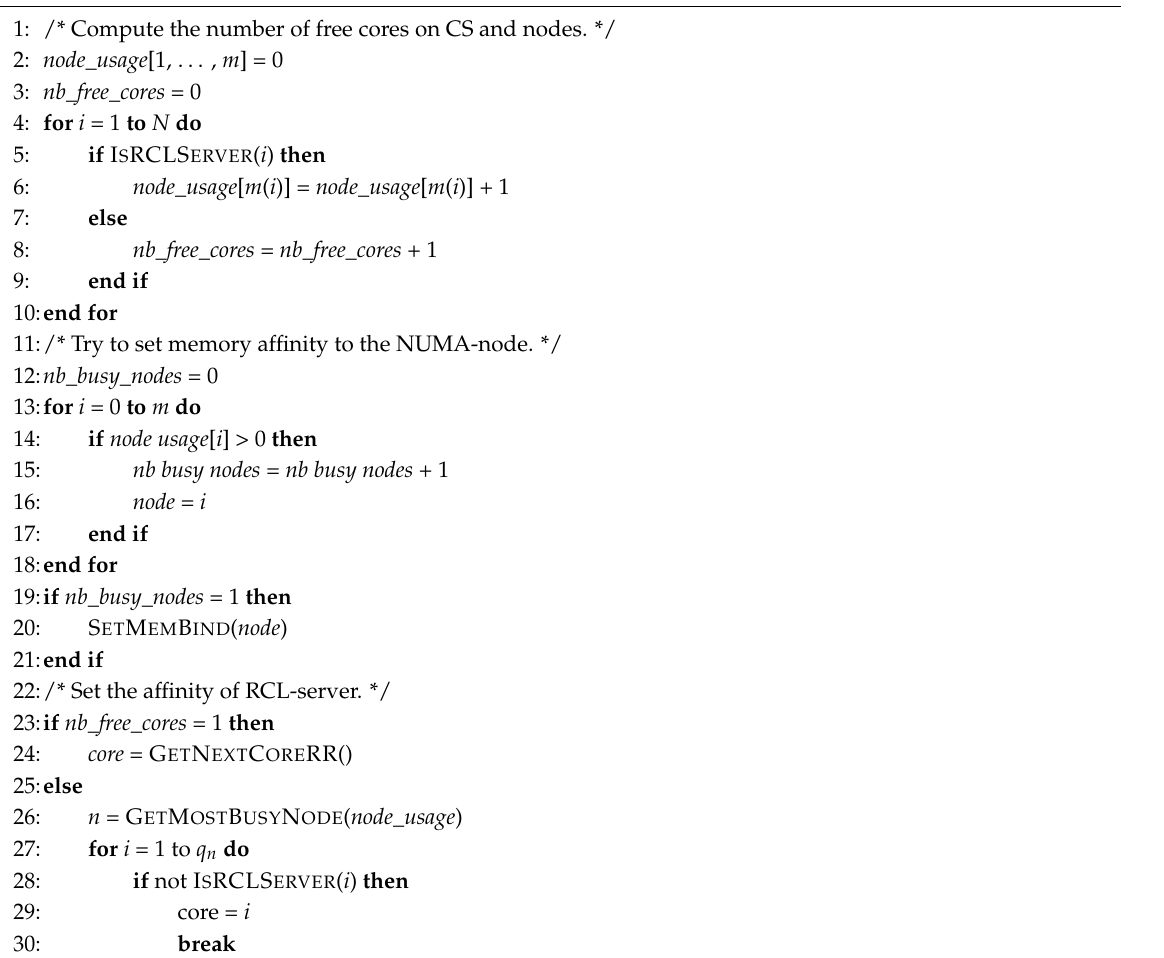
Algorithm 1. Algorithm 1. RCLLockInitNUMA.